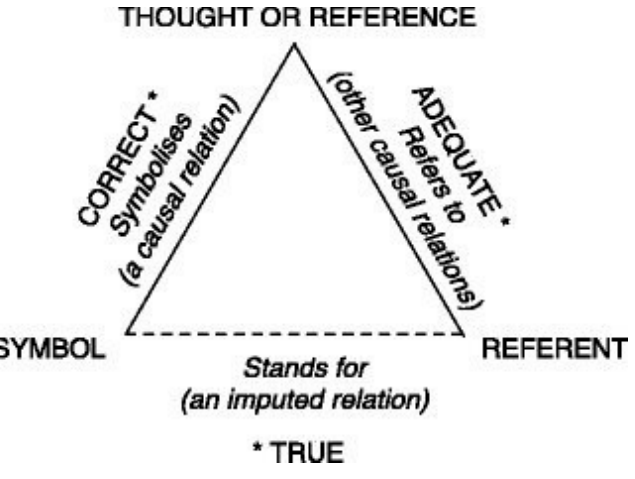
Figure 4. The Semiotic triangle [81] (p.